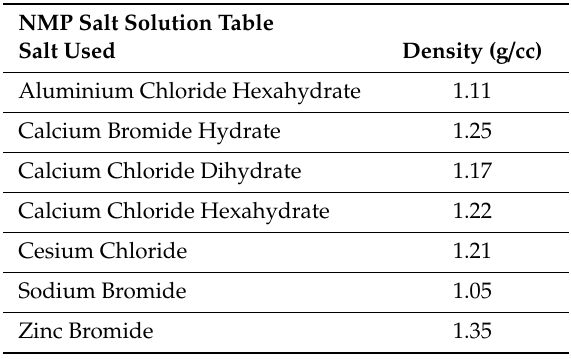
Table 4. Density of NMP salt